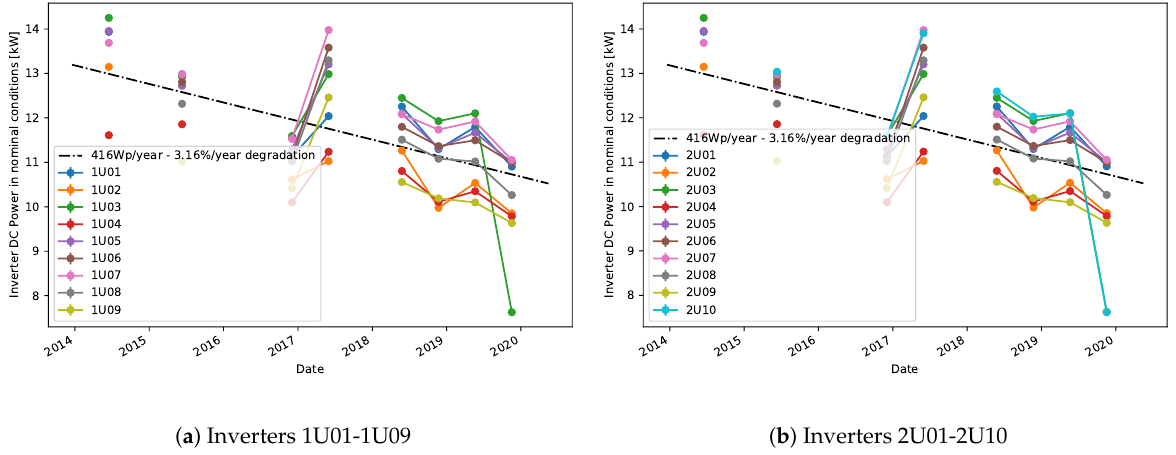
Figure 6. Predicted NOCT power for all inverters of plant